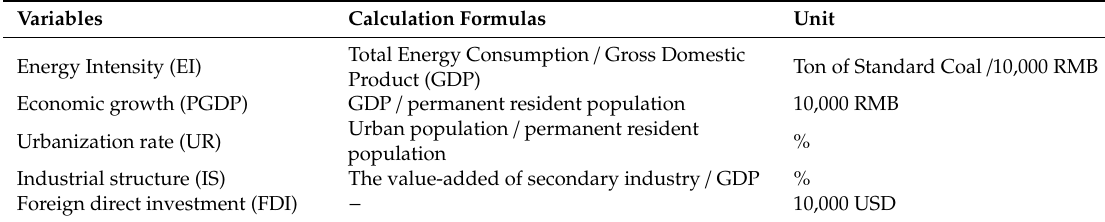
Table 4. The variables and related calculation